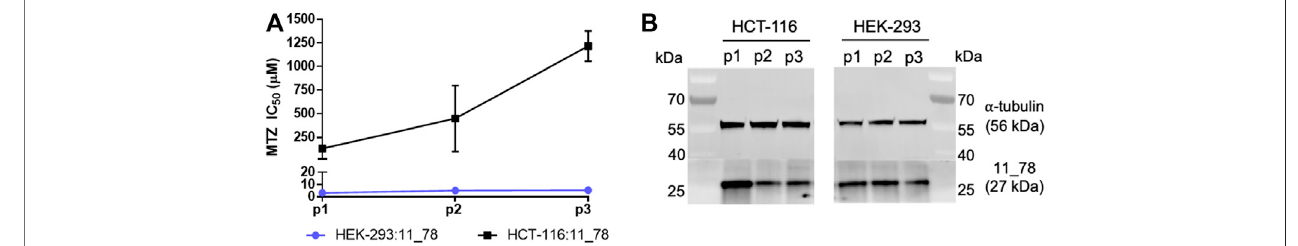
FIGURE6 | Metronidazole-sensitivity and 11_78 expression levels from HEK-293:11_78 and HCT-116:11_78 cell lines at three successive passages. At passage 1, 2, and 3 (days 7, 13, and 16 post-thaw, respectively), HEK-293:11_78 and HCT-116:11_78 cell lines were challenged with metronidazole (MTZ) (0 – 2,000 µM) for 48 h. Followingdrug incubation, cell viability at each metronidazole concentration wasassessed byMTS assay and IC 50 values were calculated. Datapresented are the average of two technical replicates ± SD (A) . In parallel, samples of each cell line at passage 1, 2, and 3 were taken, lysed with RIPA buffer and probed for NfsA expression by immunoblot using an NfsA polyclonal primary antibody and an anti-IgG HRP conjugate secondary antibody. The expression level of α tubulin in samples was determined via immuno fl uorescence detection and served as a loading control (B) .